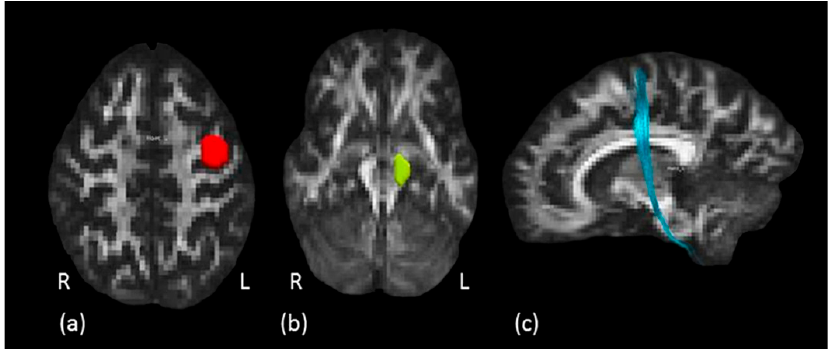
Figure 4. Hand motor tract dissection. ( a ) The red ROI is defined around the left knob-like structure on axial plane and ( b ) the green ROI is defined around the left cerebral peduncle. ( c ) In light blue, example of left hand motor fibers tractography reconstruction in a representative subject, sagittal view.